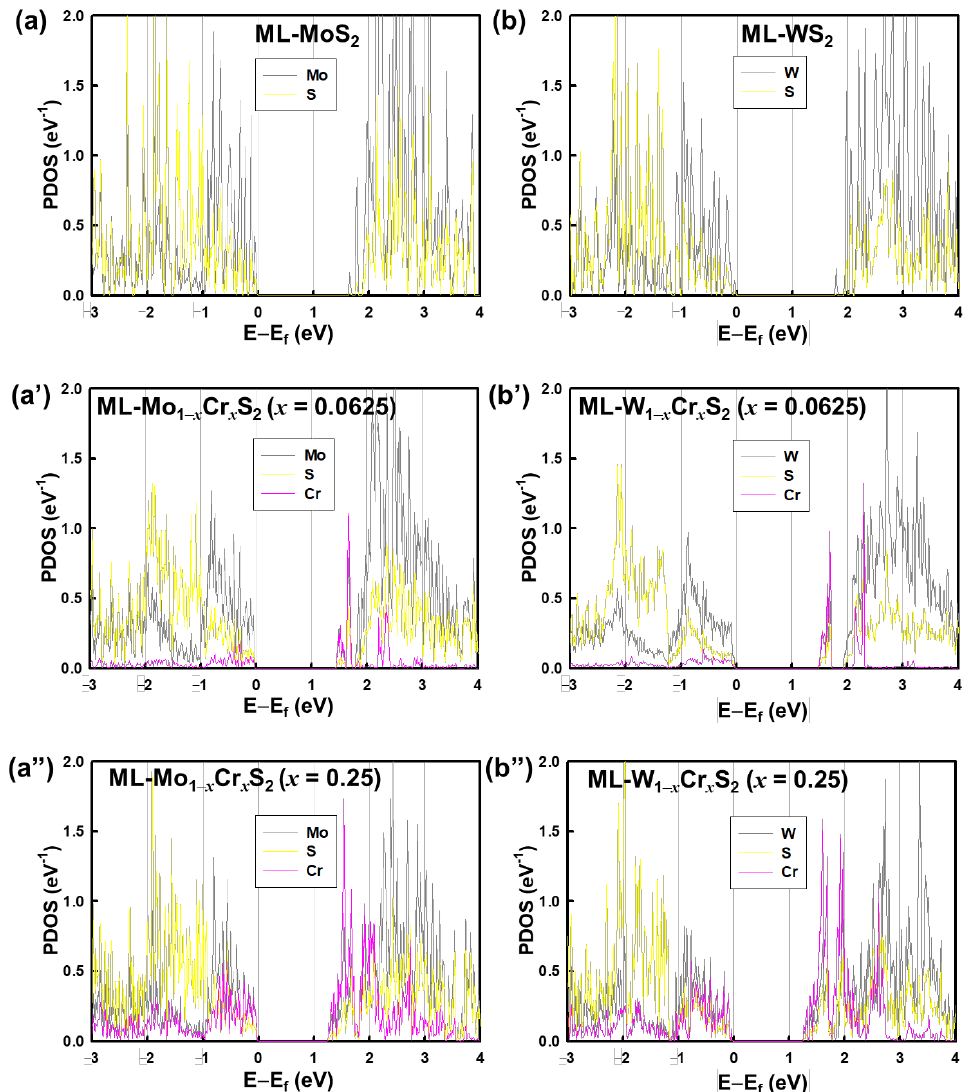
Figure 3. The projected densities of states (PDOS) of ( a , a ’, a ’’) ML -Mo 1- x Cr x S 2 and ( b,b ’, b ’’) ML -W 1- x Cr x S 2 with respect to each element and different mole fractions, where the valence band maximum was set to zero. The values of PDOS were normalized by the supercell size, where the sizes were 16 and 4 for x = 0.0625 and 0.25, respectively. The PDOS contributed by the Cr are mainly near the bottom of the conduction bands, so the band gaps of the ML-Mo 1 − x Cr x S 2 and ML-W 1 − x Cr x S 2 were reduced.